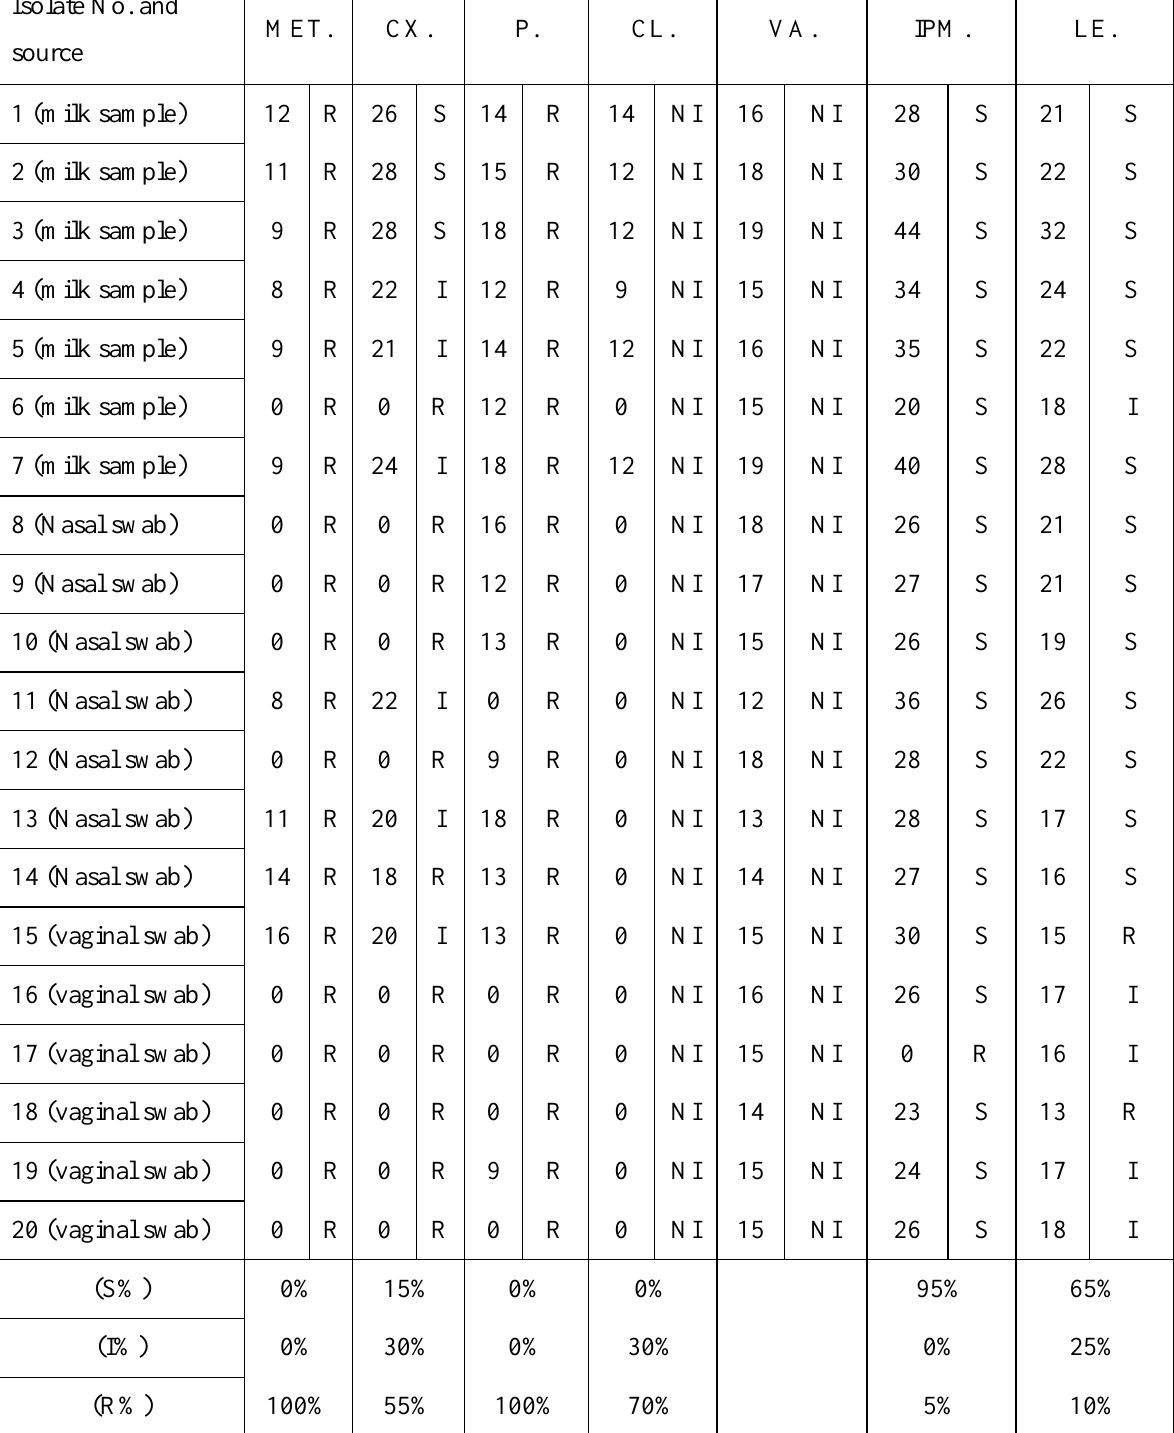
Table 4: The antibiogram profile of 20 S. aureus isolates against 7 antibacterial agents Isolate No. and source